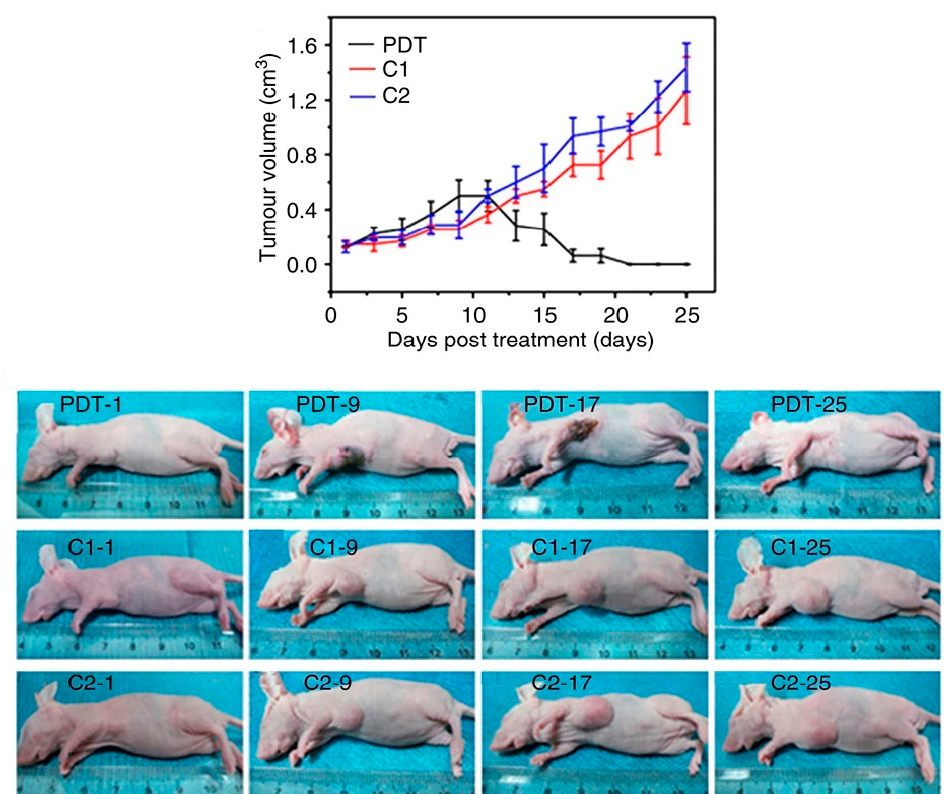
Figure 9. In vivo PDT. Time-dependent tumor growth curves ( n = 5) after different treatments. p < 0.05 for each group. Photographs of mice after various treatments on the 1st, 9th, 17th, and 25th day. (PDT: GQDs and light irradiation; C1: GQDs only; C2: light irradiation only.) Adapted from